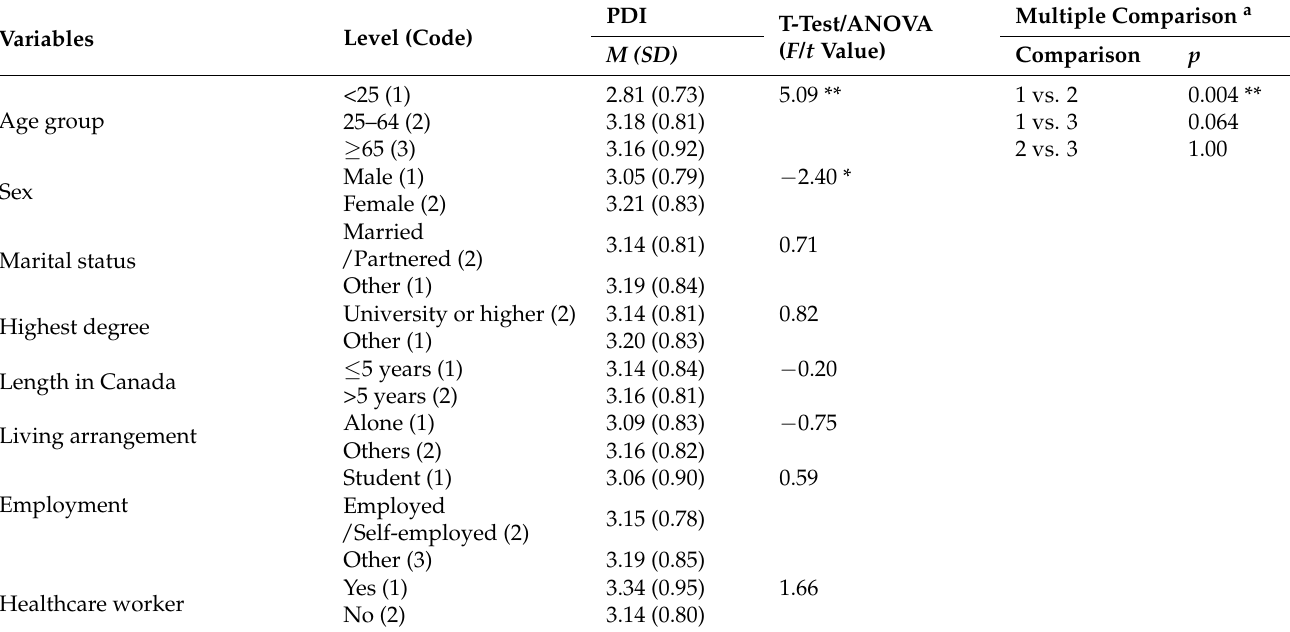
Table 2. Independent sample difference test on PDI stratified by sociodemographic